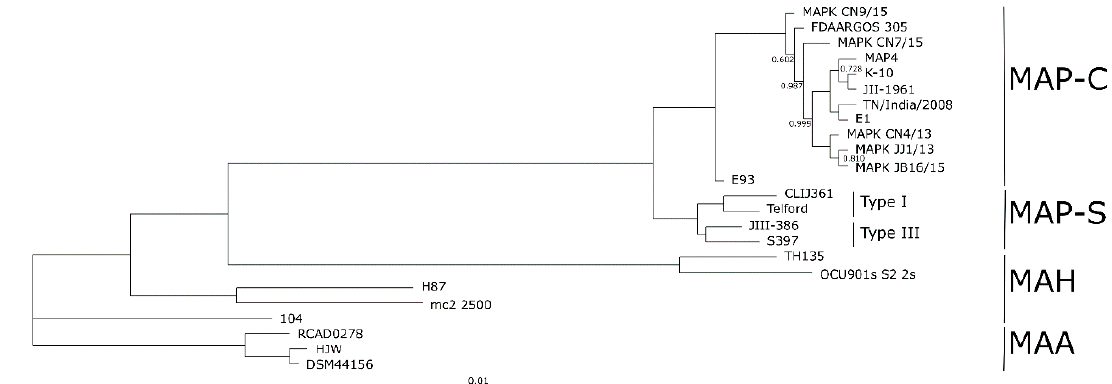
Figure 7. Phylogenetic tree of 24 selected Mycobacterium avium ( M. a .) complex strains. These strains belong to the different subspecies paratuberculosis (MAP), hominissuis (MAH), and avium (MAA), originating from different locations and hosts (see Table 1). The phylogenetic tree was constructed from concatenated core gene alignments (2807 genes per genome, 67,368 genes in total) based on the approximately Maximum-Likelihood method FastTree 2.1 [64] using the Jones-Taylor- Table [113]. To account for the varying rates of evolution across sites, the CAT approximation with 20 rate categories was used. The core has 923,637 AA-residues/bp per genome, 22,167,288 in total. To estimate the branch support, SH values were calculated by FastTree 2.1 [64]. The majority of branches showed a perfect support value of 1000, branches with lower SH values are indicated in the tree.